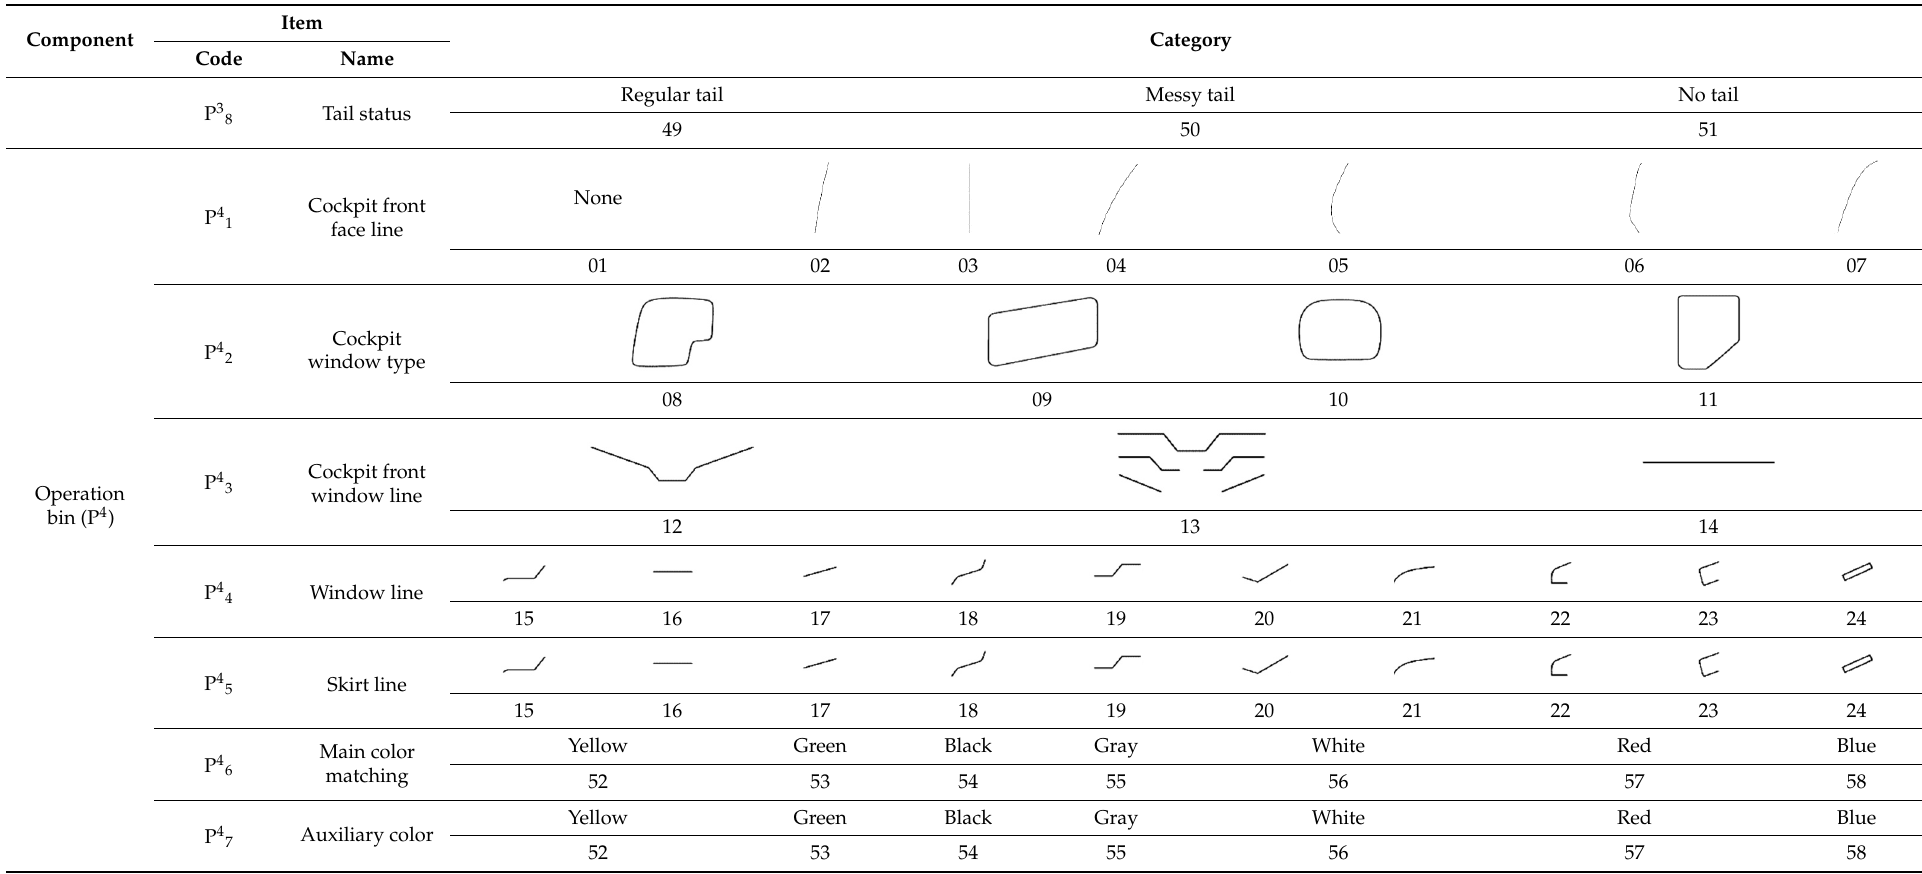
Table 7. Modeling-feature-category coding of truck cranes with visual sequence.